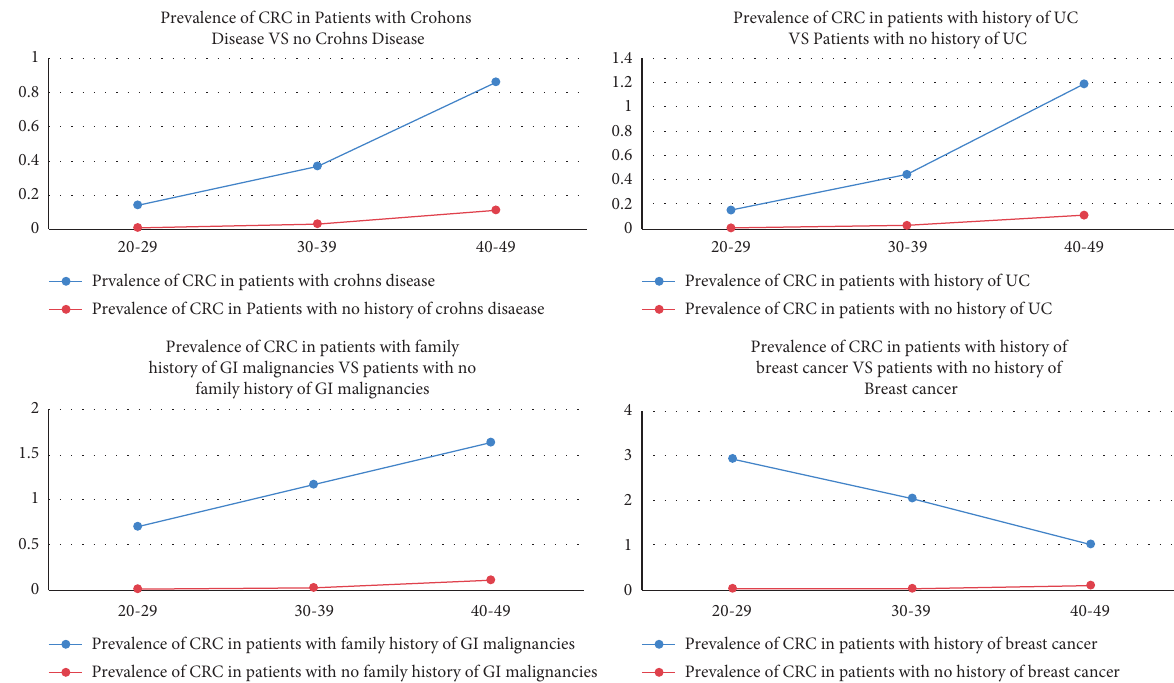
Figure 5: Prevalence of CRC in patients with a history of UC and CD, with and without breast cancer in different age groups. Table 2: Predictors of CRC in young adults. OR 95% CI Males vs. females 1.355 1.317 to